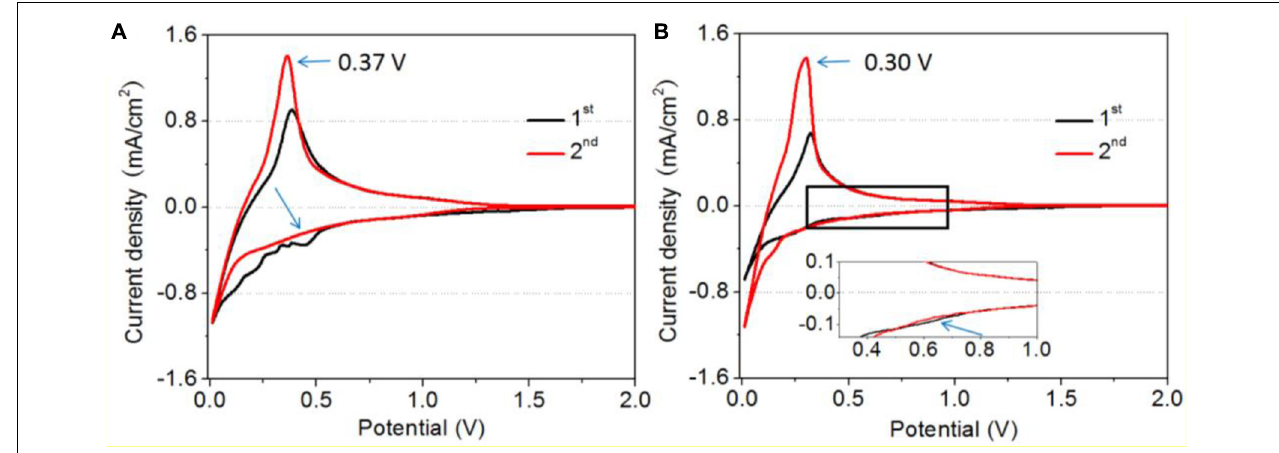
FIGURE 5 | Cyclic voltammograms of graphite electrode in 1.0 M LiPF 6 -EC / EMC (1:2) without (A) and with 5% PS (B) . The diameter of graphite electrode was 13.0 mm.